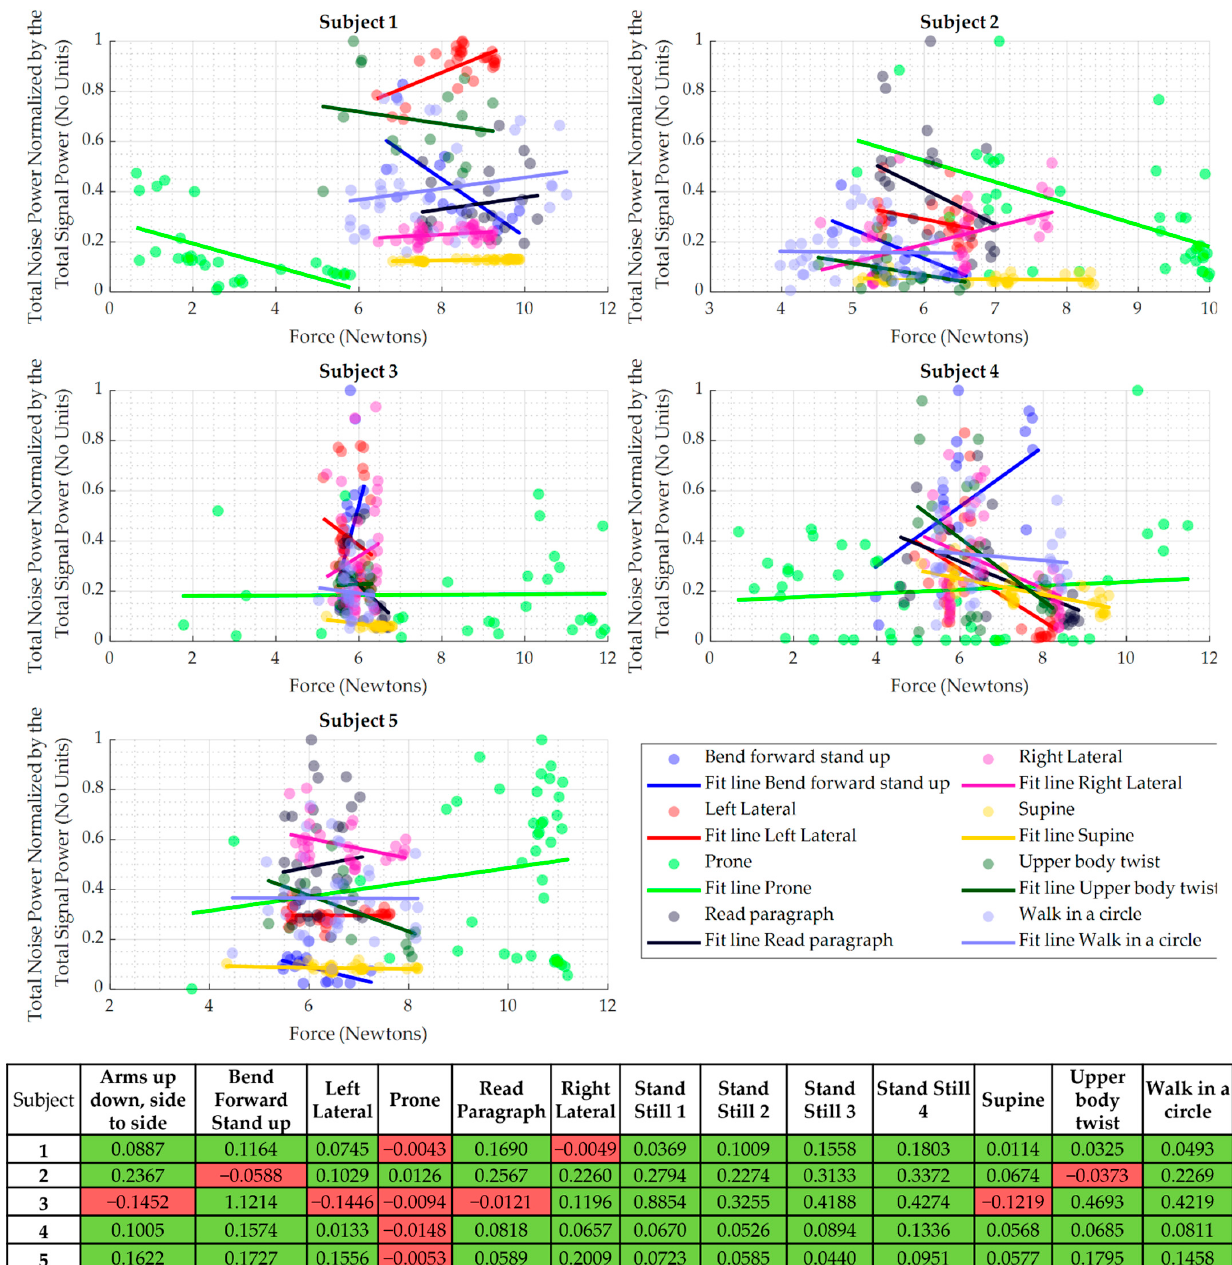
Figure 13. Relationship between WPAS force RMS and heart sound noise level. There are consistent negative slopes for four of the five subjects for left lateral and supine activities. However, subject 5 shows only a marginal inclination towards a negative slope between the force RMS and noise levels in left lateral activity. Similarly, the only marginally negative trend in supine activity is observed for subjects 1, 2, and 5. These find- ings suggest that the trends across subjects are inconsistent, and a generalized relationship between WPAS force RMS and heart sound levels is not easily